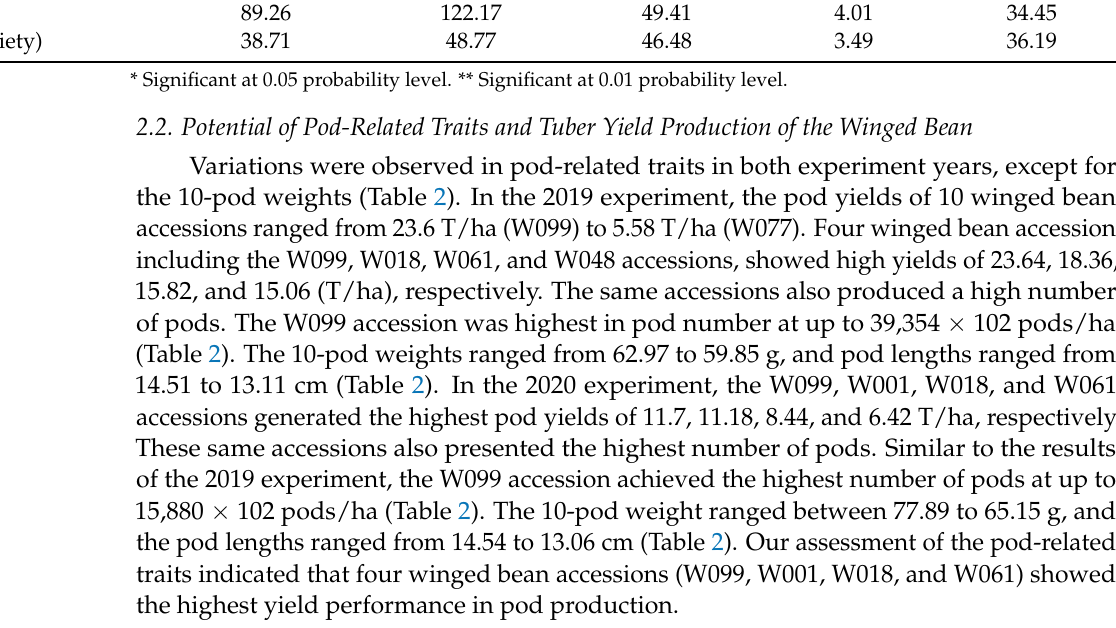
15,880 × 102 pods/ha (Table 2). The 10-pod weight ranged between 77.89 to 65.15 g, and